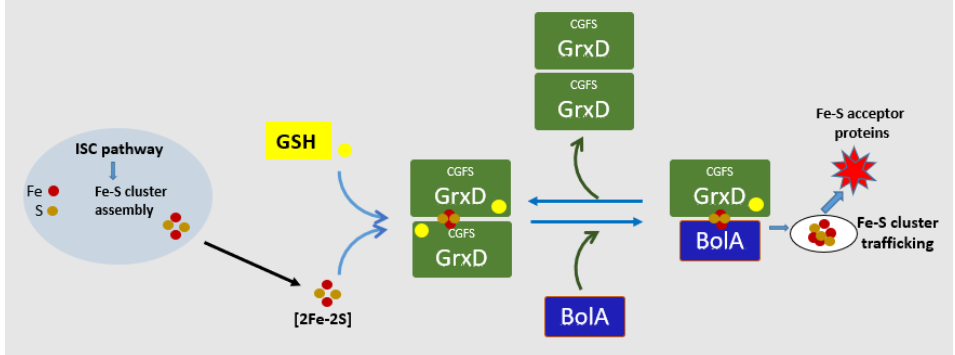
Figure 4. Schematic diagram of FeS cluster transfer/maturation in E. coli . In E. coli the synthesis of FeS clusters is catalyzed by complex machinery that includes ISC system. [2Fe-2S] clusters are distributed in a process that depends on the Glutathione-S-transferase (GSH, colored in yellow), CGFS-type GrxD homodimers (colored in green) and GrxD-BolA heterocomplexes, (BolA colored in blue). The reactions are reversible and monomeric BolAs or GrxD-BolA could be reformed. The physiological relevance of each form has not been elucidated but this interconversion could play a role in FeS trafficking and